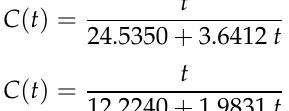
Figure 3. Kinetic Model, 2 mm matrix. Statistical values are reported in Table A2.